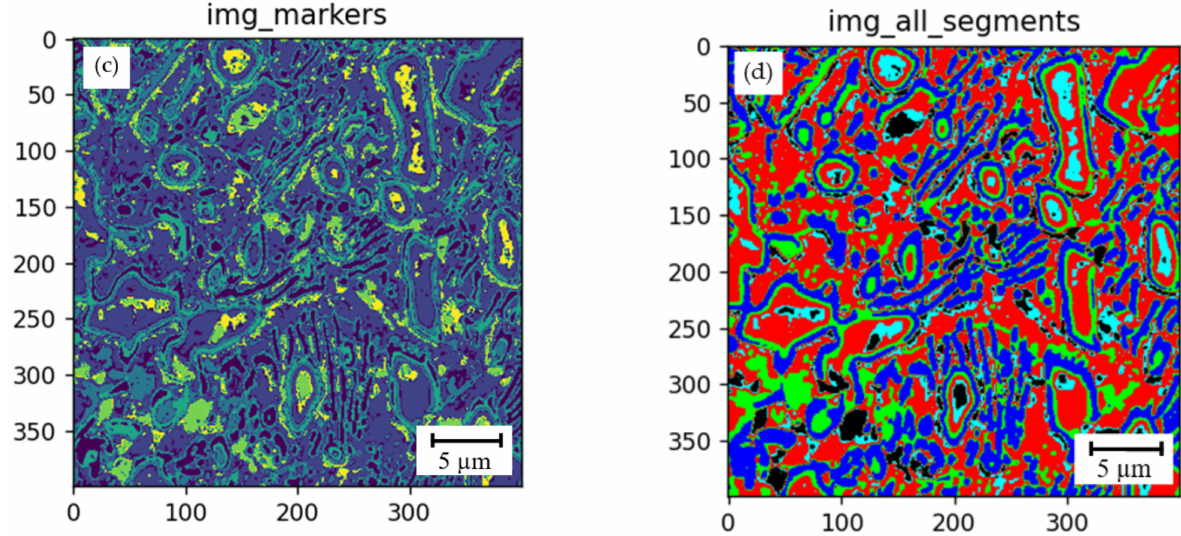
Figure 2. Illustrations of the marker-based watershed segmentation workflow on a 2D image of the hypereutectoid steel microstructure with 1.8% C after annealing (contains all structural components). ( a )—the gray-level structure of the steel after annealing (etching with 4% HNO 3 solvent); ( b )—the histogram of gray values image after non-local means denoising and equalizing for preserving textures; ( c )—markers image after exposure (labeling 5 components of phases); ( d )—the segmented image with regions resulting from the marker-based watershed segmentation (the color corresponds to the segment; black–the structurally free graphite zones; blue- с ement plates in perlite and matrix areas are close in content to the averaged value by perlite component; red-carbide phase with non- equilibrium stechiometric composition (depleted carbon) and alloy steel matrix; green-depleted by the steel matrix components content; azure-carbide phase with a steichiometric composition close to the equilibrium